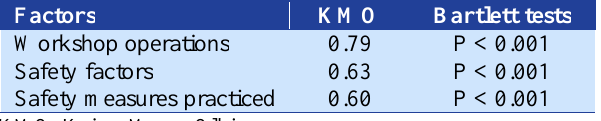
Table 4. Kaiser-Meyer-Olkin (KMO) and Bartlett tests of